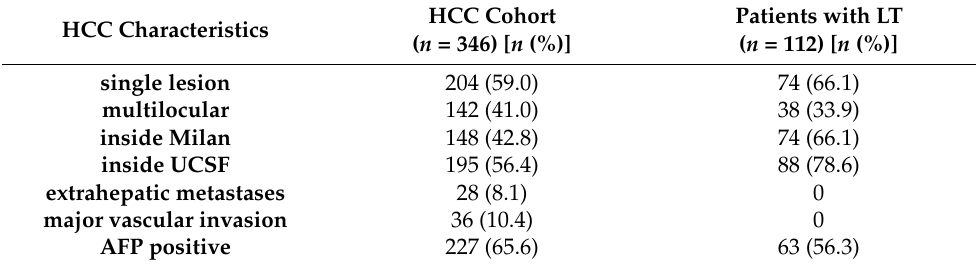
Table 2. HCC expression at initial diagnosis in the entire HCC and the LT cohort. HCC